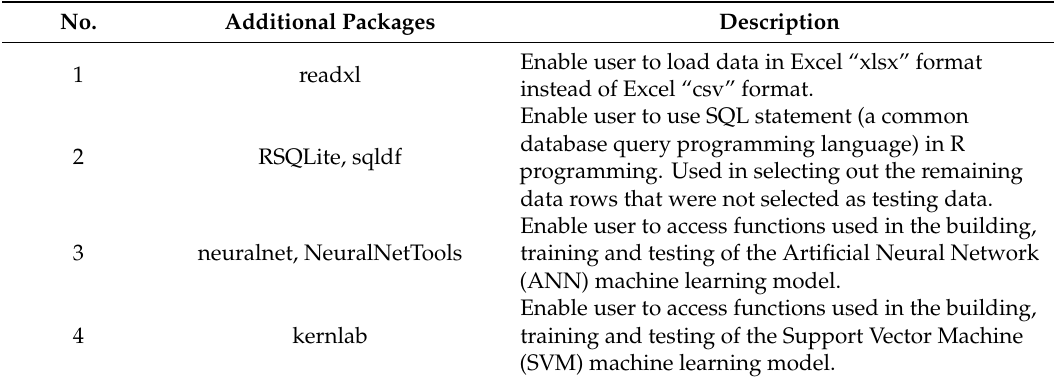
Table 4. Additional packages installed into R programming